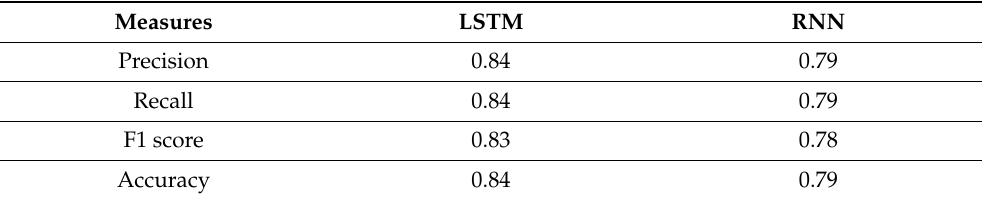
Table 4. Results of using deep learning modes LSTM and RNN in thematic analysis of concor- dance